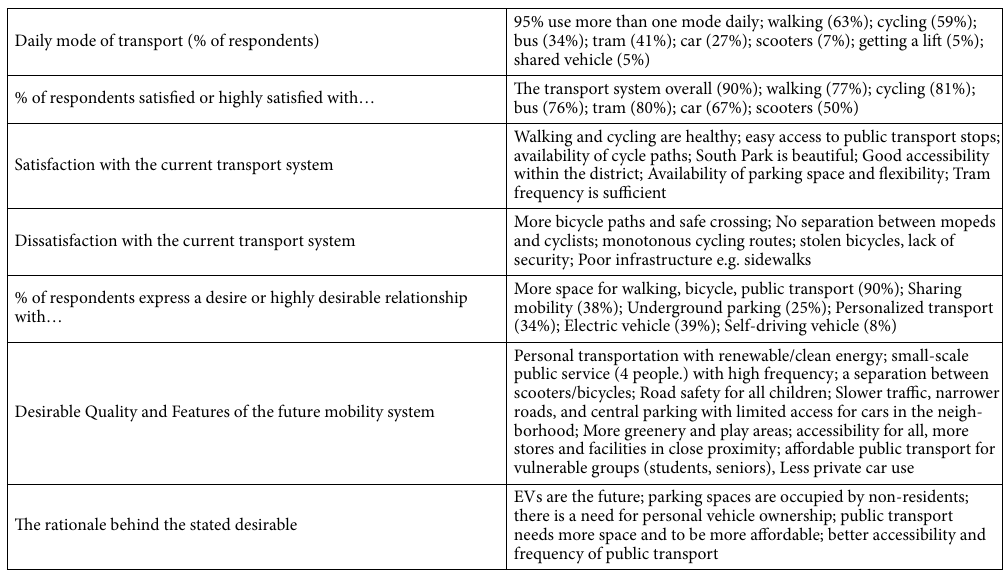
Table 4. Summary of and selected outcomes from the public survey and interview (n =